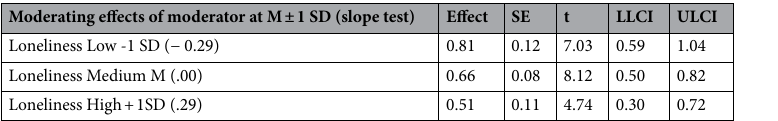
Table 6. Slope test corresponding to the moderating effects of the moderator (loneliness) and negative emotions as dependent variable.